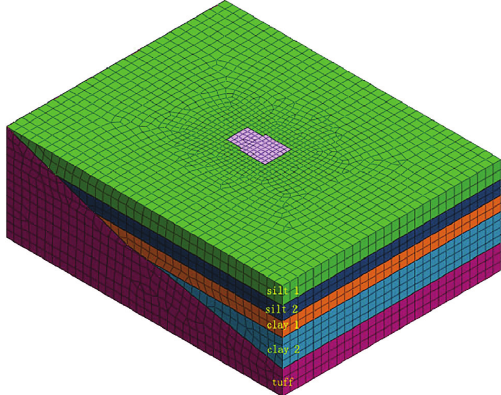
Figure 6: Overall calculation model of foundation pit. Table 2: Material parameters of supporting structure.